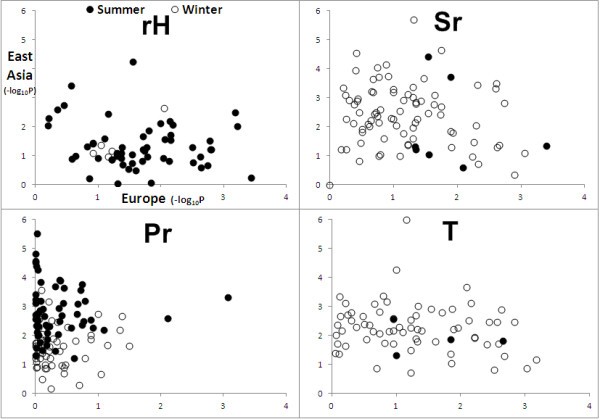
Comparison between Europe and East Asia specific signals of selection. At each putative hit, we further explored the origin of the signal by analyzing each continent in turn while holding all other data constant. Only the two best-represented continents, Europe and East Asia, yield meaningful signals. Panels depict –log10P in Europe plotted against –log10P for East Asia under the CS = 0 for each of the four climate variables (Pr = precipitation, rH = relative humidity, T = temperature, and Sr = solar radiation). The lack of strong correlation suggests a tendency for climate-based selection to have operated independently and largely on different subsets of genes in the different geographic regions.